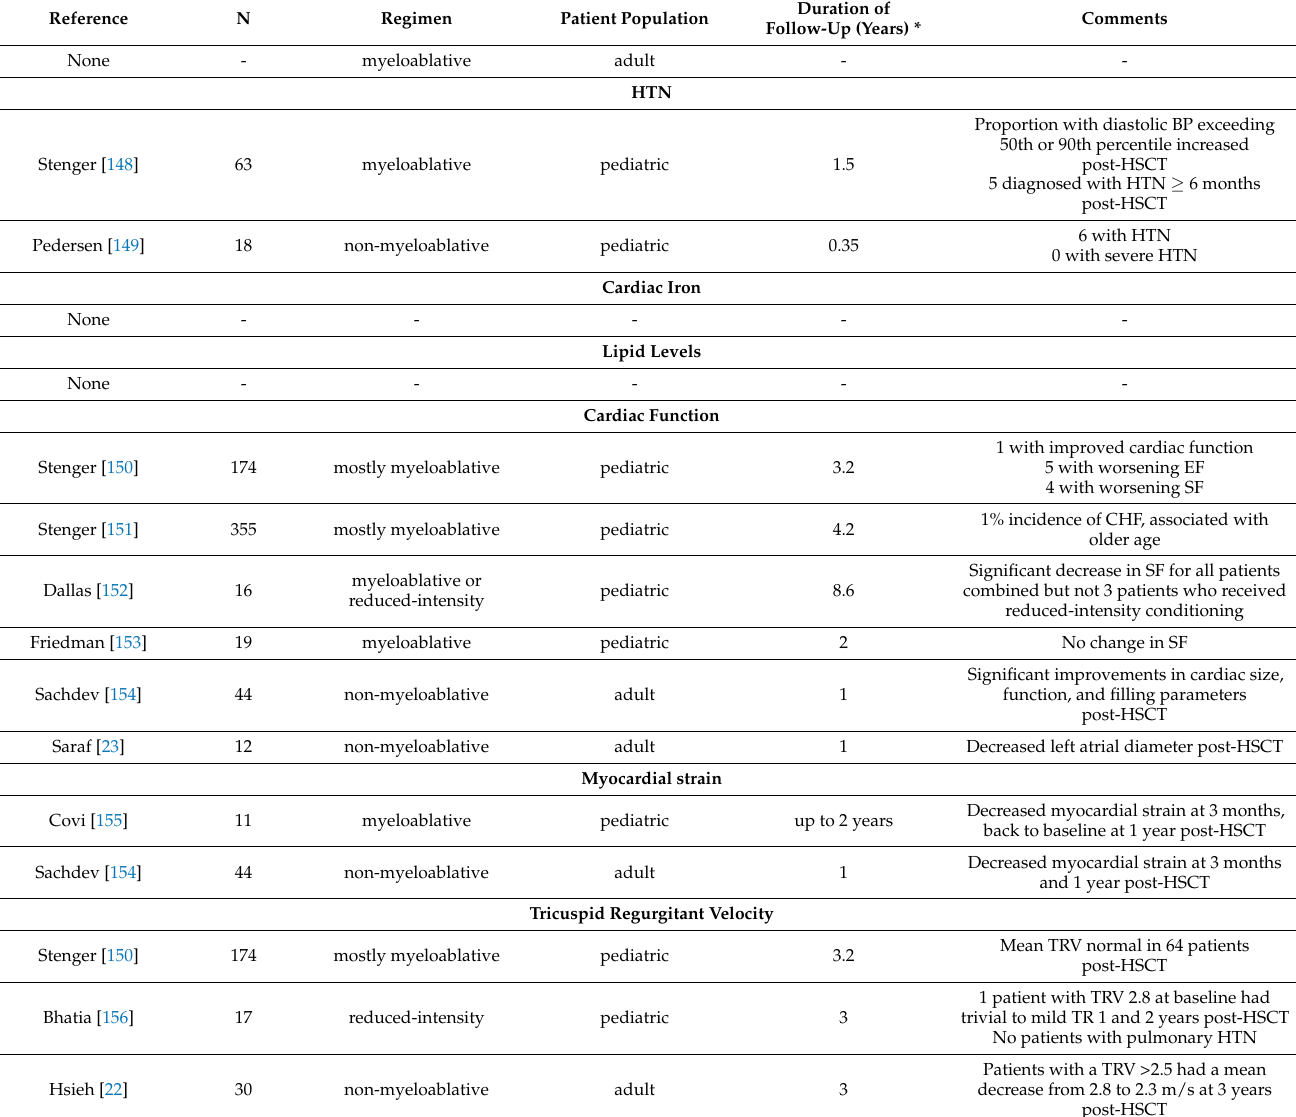
Table 2. Late effects studies involving the heart and cardiovascular system in patients with SCD who receive